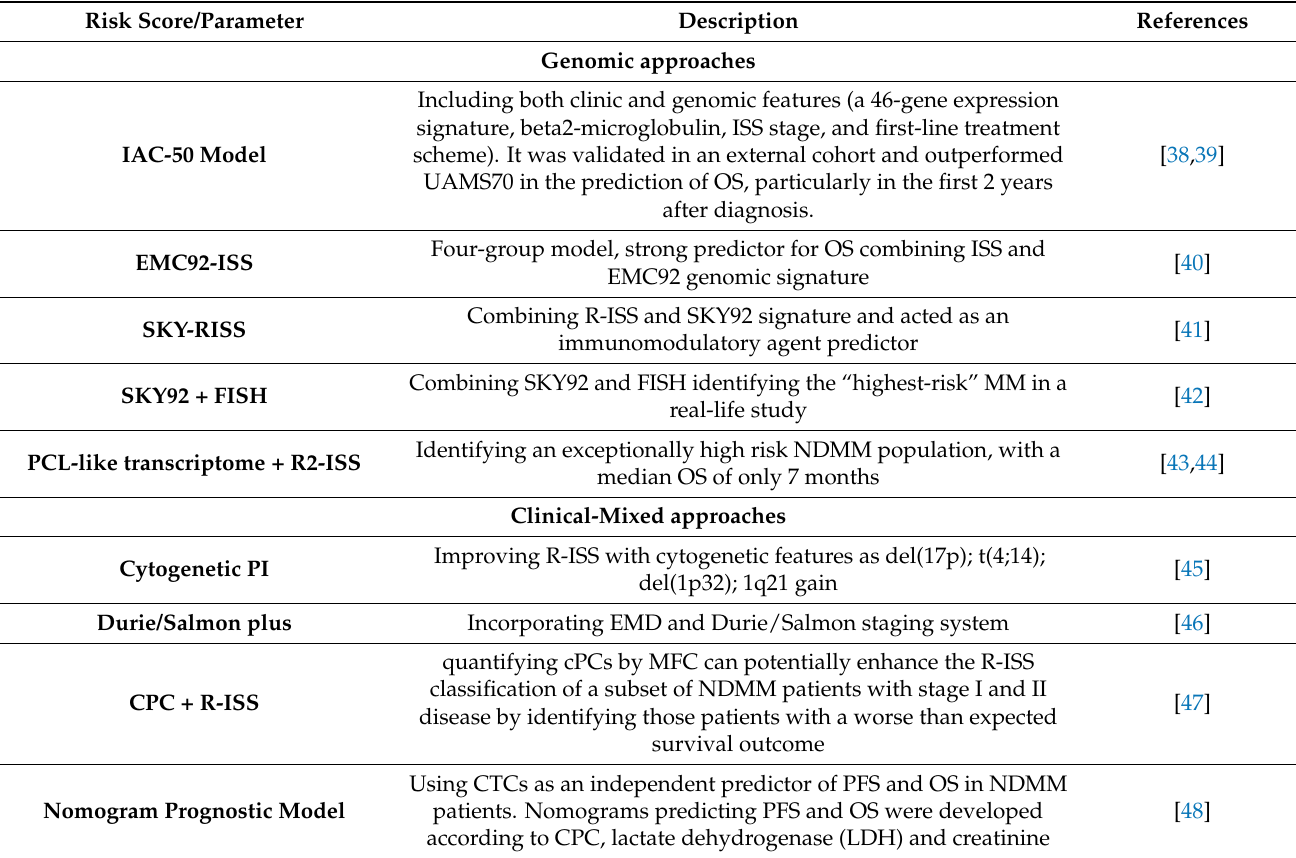
Table 1. Other risk stratification